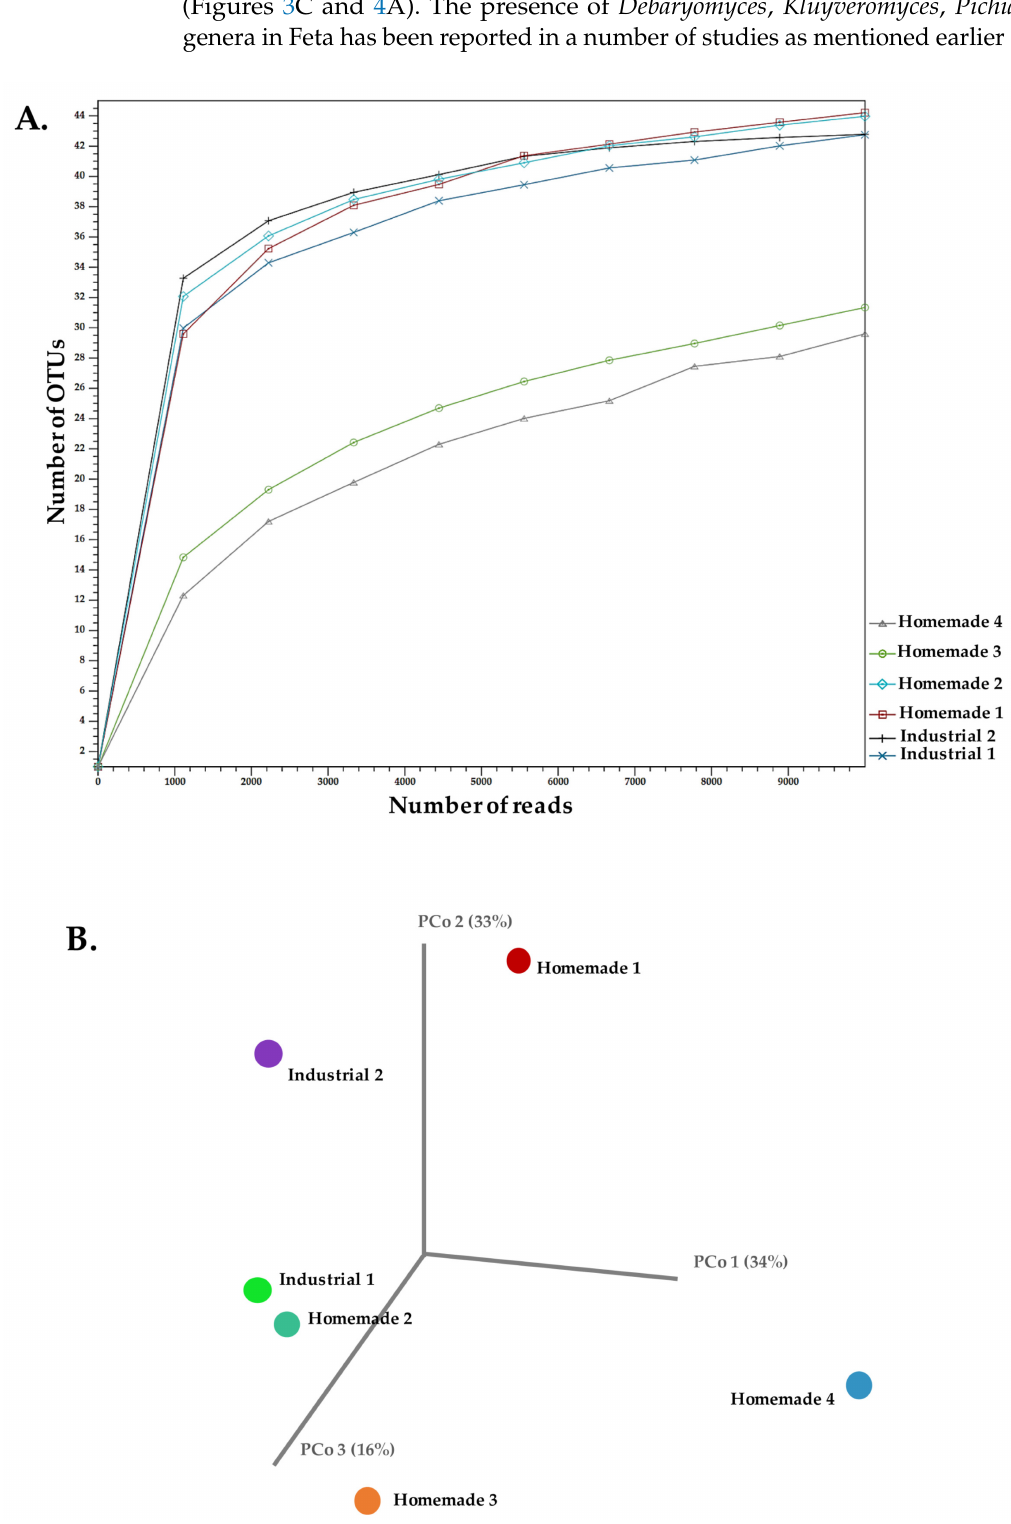
Figure 4. Alpha-diversity analysis of ITS reads for a maximum depth of 10,000 read counts measured using the total number of OTUs at genus level of industrial and homemade Feta cheese samples ( A ). Beta-diversity presented in a principal coordinate analysis (PCoA) employing the Bray–Curtis distances for the same samples ( B